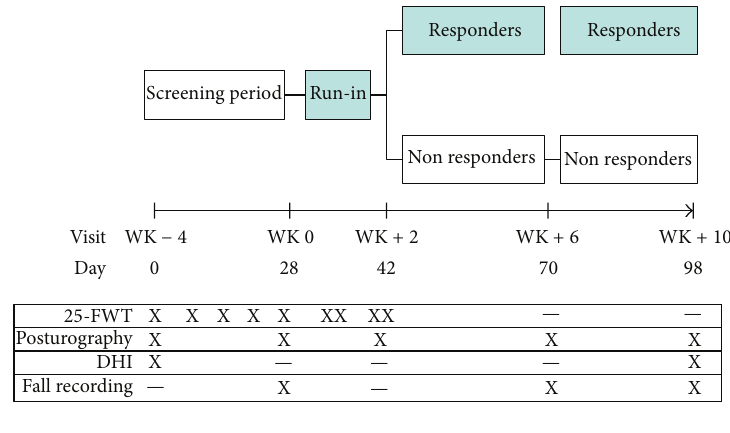
Figure 1: Study design and assessments. PR: prolonged release; 25-FWT: 25-timed foot walking test; DHI: dizziness handicap